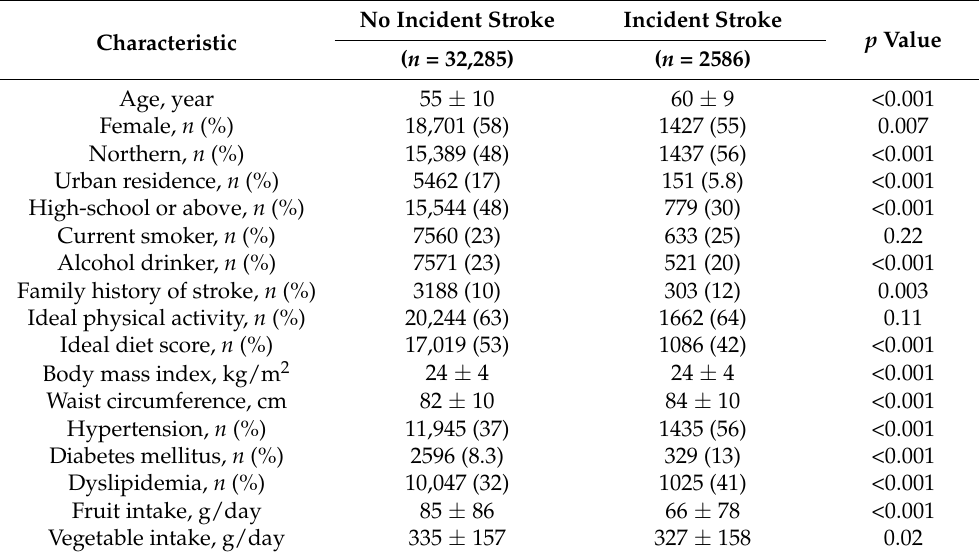
Table 1. Baseline characteristics of the